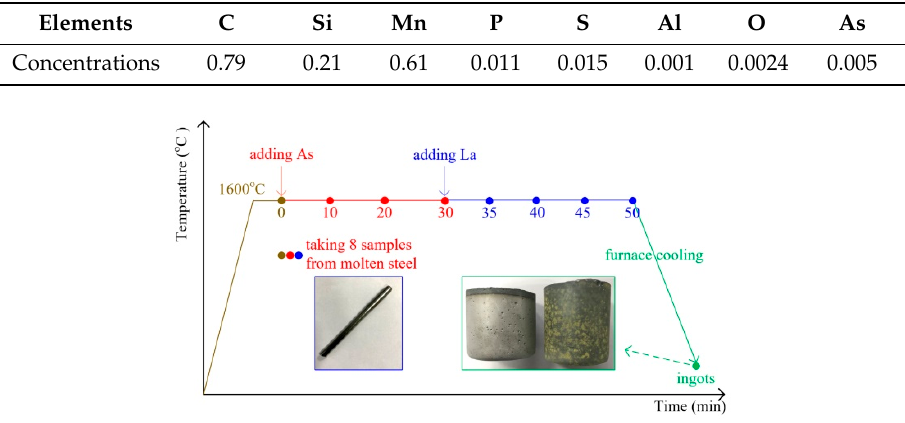
Table 1. Chemical compositions of the obtained rods (mass%).